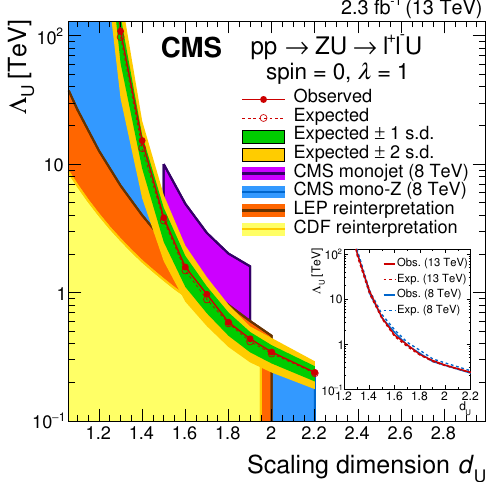
Figure 10 . The 95% CL lower limits on the e(cid:11)ective unparticle cuto(cid:11) scale (cid:3) U for a (cid:12)xed coupling (cid:21) = 1. The results from the CMS monojet [1] and mono-Z [2] searches, as well as a reinterpretation of LEP and CDF searches [3] are shown for comparison. The LEP results assume a coupling of unparticles to Z bosons and photons. The CDF (CMS) monojet result is based on a gluon-unparticle coupling operator (gluon- and quark-unparticle coupling operators). The inset compares the expected and observed limits for the CMS mono-Z analyses at Note that the cuto(cid:11) scales (cid:3) U for di(cid:11)erent operators do not have to be identical. Consequently, the comparison shown here with the results other than the CMS 8 TeV mono-Z analysis is only